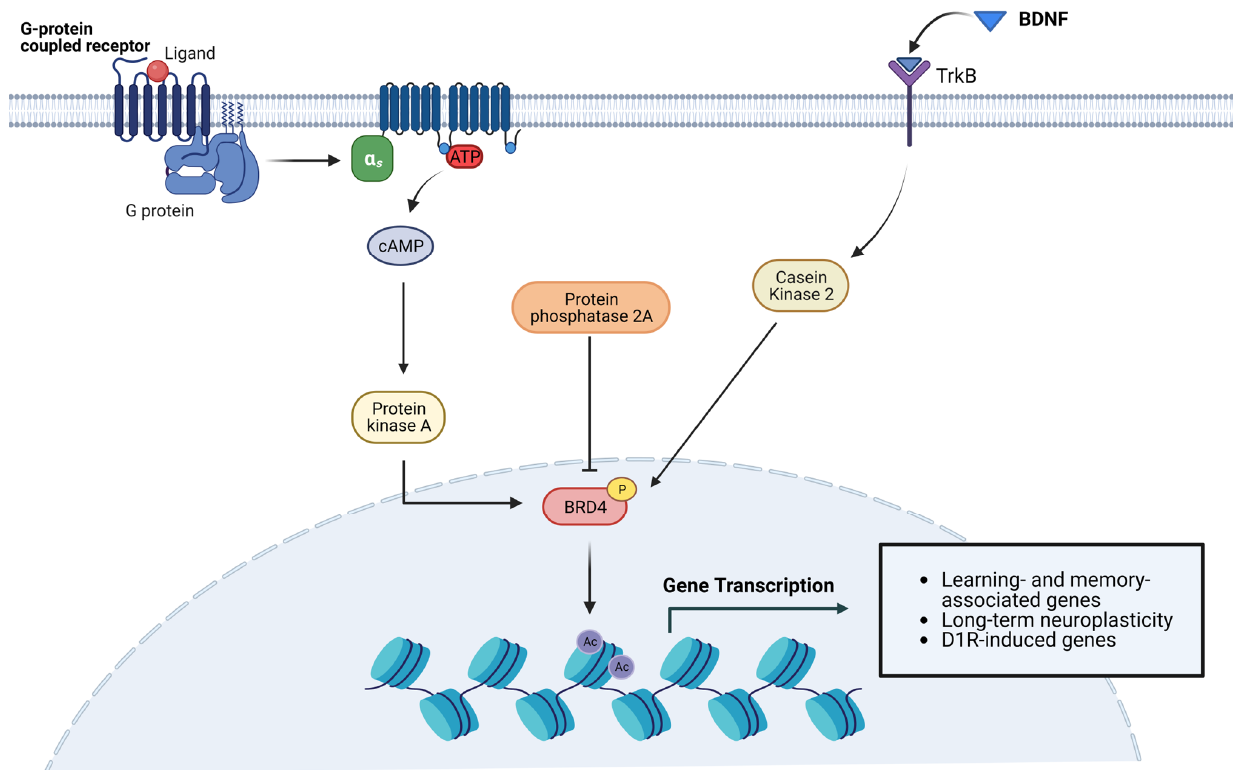
Figure 2. Proposed model for BRD4 activation in neurons. Gs protein-coupled receptors and TrkB activation recruit cAMP/PKA axis and casein kinase 2 (CK2), respectively, promoting BRD4 phos- phorylation and subsequent Kac recognition on chromatin. This event results in the transcriptional activation of genes involved in learning and memory, neuroplasticity, as well as upregulation of genes mediated by D1R. Protein phosphatase 2A inhibits BRD4 recruitment to chromatin through dephosphorylation [15,66–68]. This figure is created with BioRender.